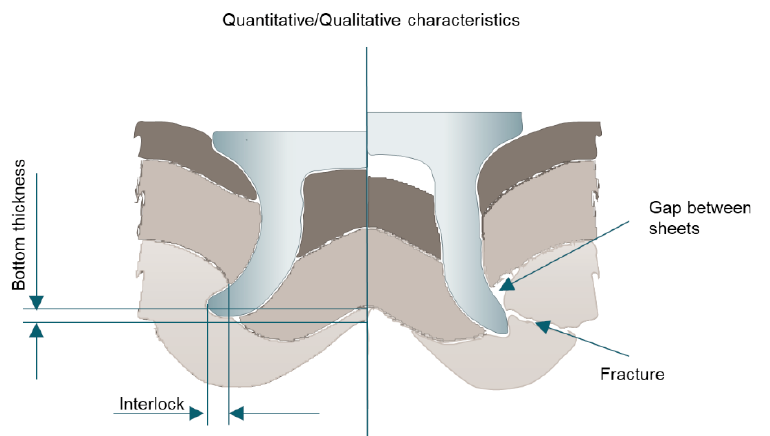
Figure 8. Joint quality issues in self-piercing riveting.